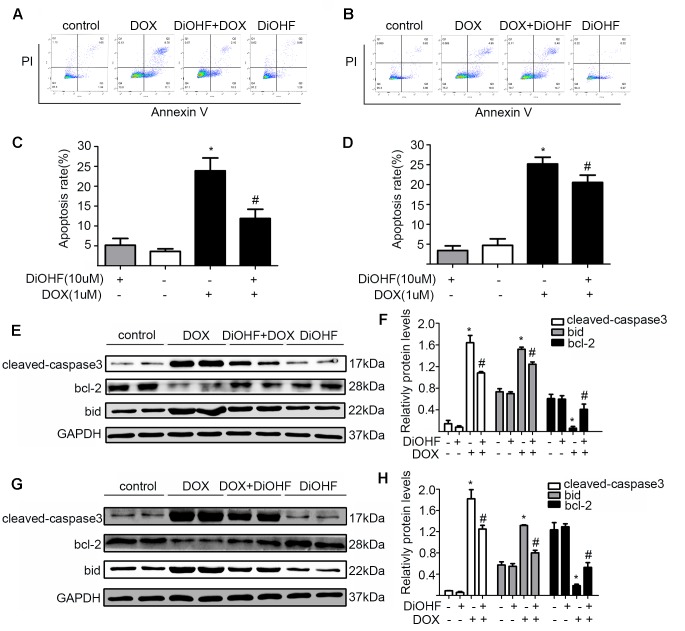
DiOHF prevented and reversed the DOX-induced apoptosis. (A) H9C2 cells were pre-treated with DiOHF for 2 h followed by the treatment with DOX for 24 h. Apoptosis was assessed by flow cytometry. (B) H9C2 cells were treated with DOX for 2 h followed by the treatment with DOX + DiOHF for 22 h. Apoptosis was detected by flow cytometry. (C and D) Quantitative data of the apoptosis. (E and G) Representative Western blots. (F and H) Western blot analysis for the apoptosis-associated proteins (cleaved-caspase-3, Bcl-2, and Bid). GAPDH served as the loading control. The data were analyzed by ANOVA and expressed as mean ± SEM. *P < 0.05, compared with the control; #
P < 0.05, compared with DOX.